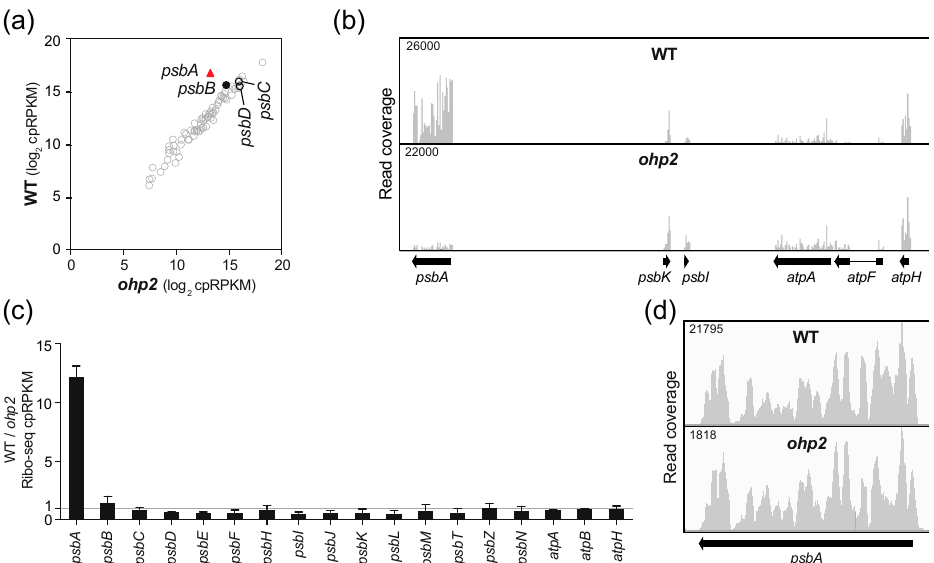
Figure 4. Ribo-seq analysis of Arabidopsis ohp2 mutants. Data for a replicate experiment are shown in Figure S1c. Symbols and nomenclature are as described in Figure 2. ( a ) Comparison of ribosome footprint abundance for all chloroplast genes in ohp2 mutants to that in phenotypically-normal siblings. ( b ) Screen capture from the Integrated Genome Viewer (IGV) showing the distribution of ribosome footprints along psbA and adjacent ORFs. ( c ) Ratio of Ribo-seq reads in the wild-type relative to the mutant for chloroplast genes encoding PSII subunits. Several atp genes are shown for comparison. The average of the two replicates (+/– SD) is shown. ( d ) Distribution of ribosome footprints along the psbA ORF. The Y-axis maxima were adjusted to facilitate comparison of ribosome distributions in the two genotypes.